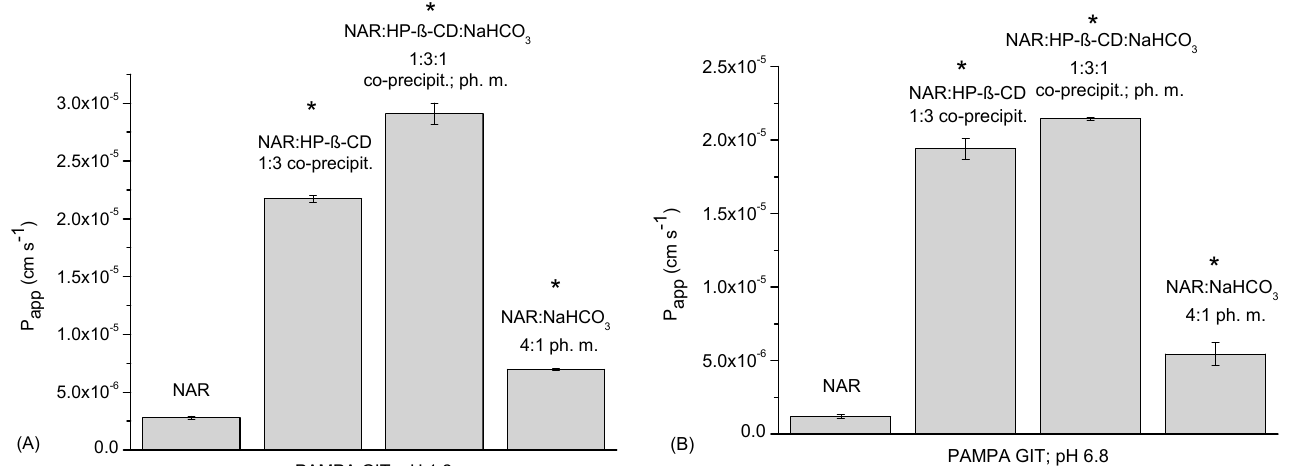
Figure 5. Apparent permeability coefficient values of NAR, the binary system (NAR:HP- β -CD) obtained by the co-precipitation method, the ternary system (NAR:HP- β -CD:NaHCO 3 ), and the physical mixture (NAR:HP- β -CD:NaHCO 3 ), determined for gastrointestinal permeability in the PAMPA GIT in an acidic pH ( A ) and a basic pH ( B ). (*) indicates statistically significant differences, p < 0.05.